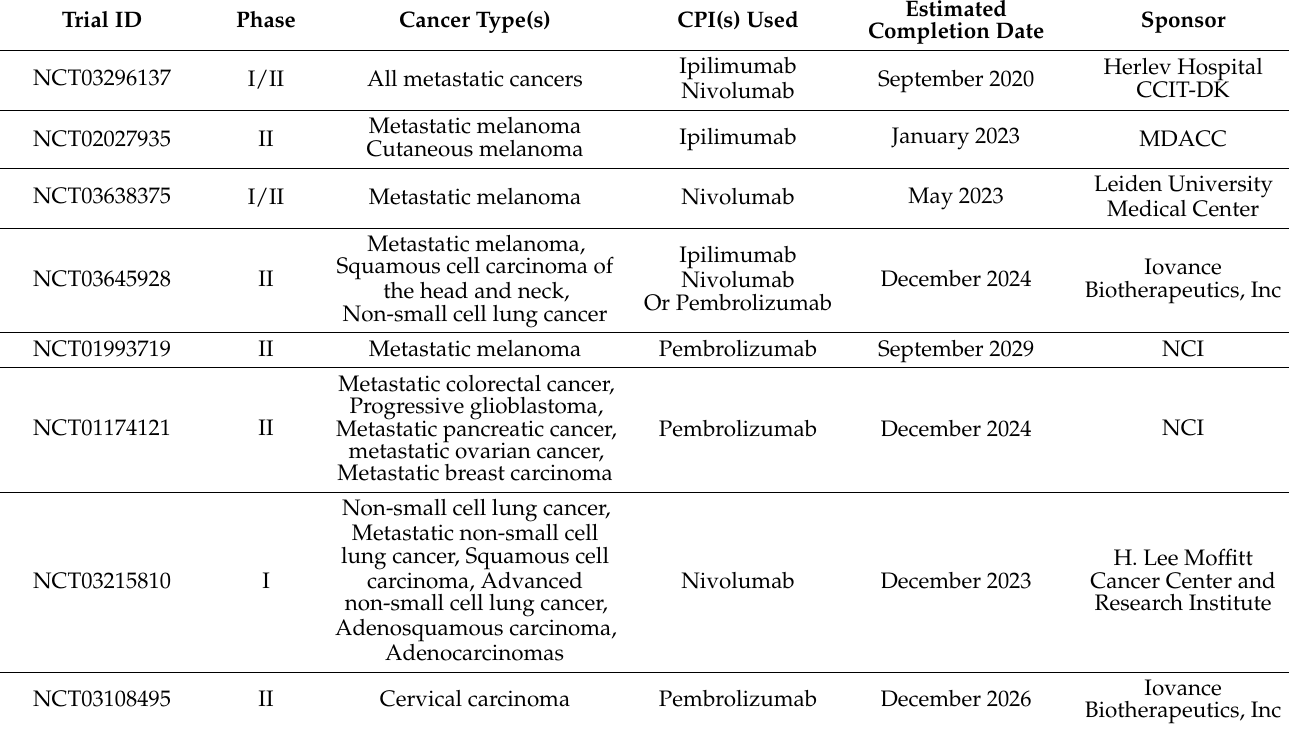
Table 1. Current TIL-based ACT clinical trials involving CPI